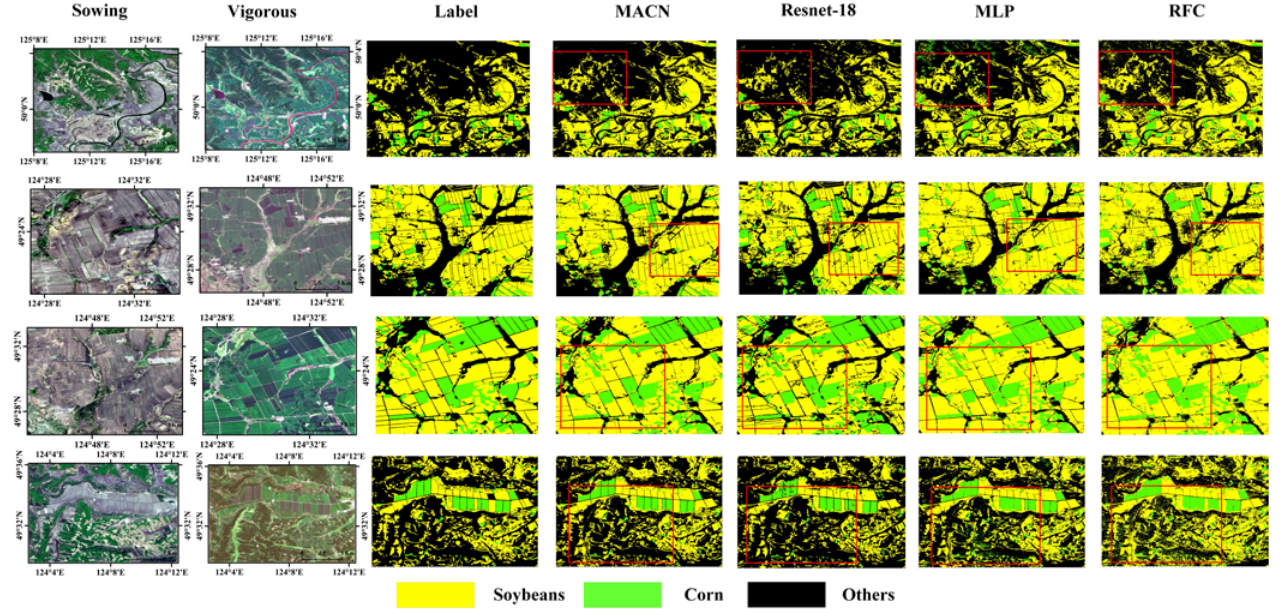
Figure 10. Enlarged views of the red boxes from the four test areas in Figure 9 (A’ corresponds to A, etc.).